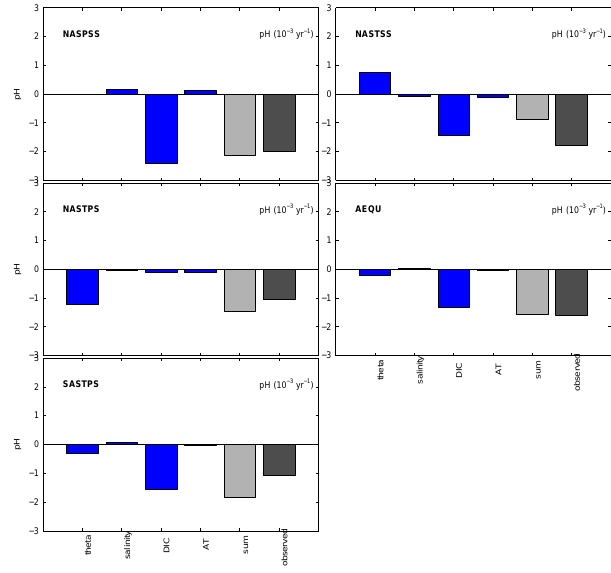
Figure 7. The long-term trends in pH from Fig. 2 decomposed into the contributions from SST, SSS, alkalinity, and DIC. Also shown is the sum of the four contributions and the actual observed trend. Note that the trend has been multiplied by 1000 for easier